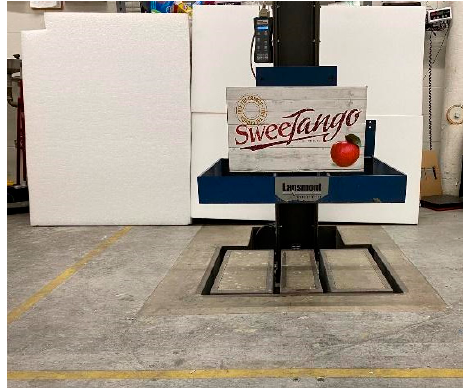
Figure 2. Packaged product on the Lansmont PDT 227.